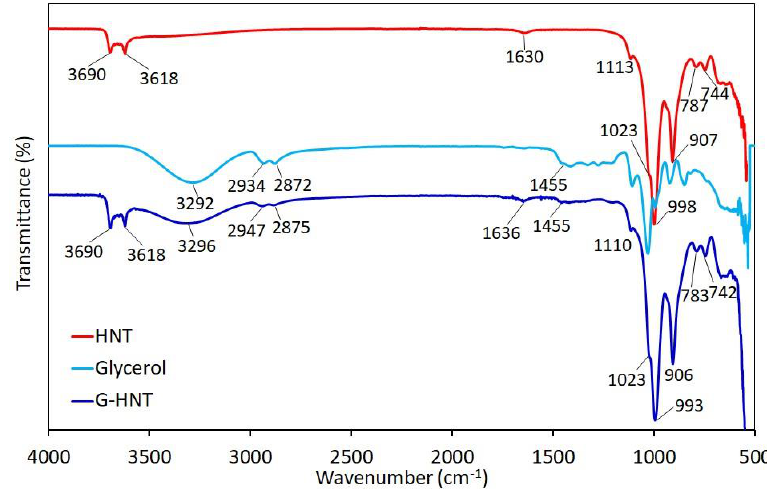
Figure 2. FTIR spectra of HNT, glycerol and G-HNT in the 4000–500 cm −1 region.